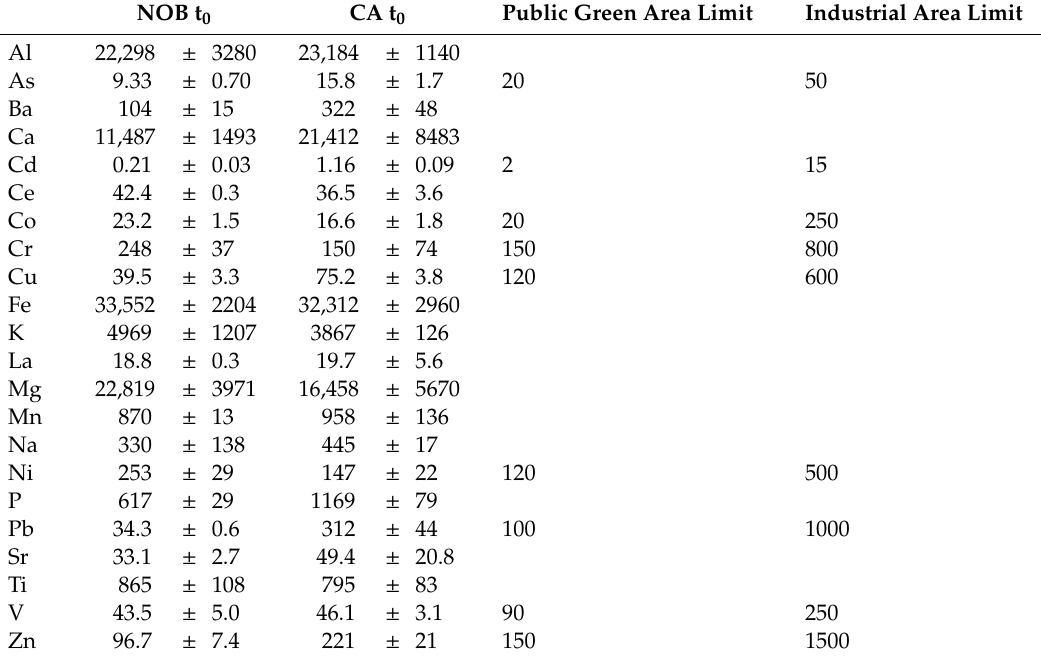
Table 2. Element concentration (mg / kg) ± standard deviation (SD) in NOB and CA sites and Italian legislation limits. NOB t 0 CA t 0 Public Green Area Limit Industrial Area